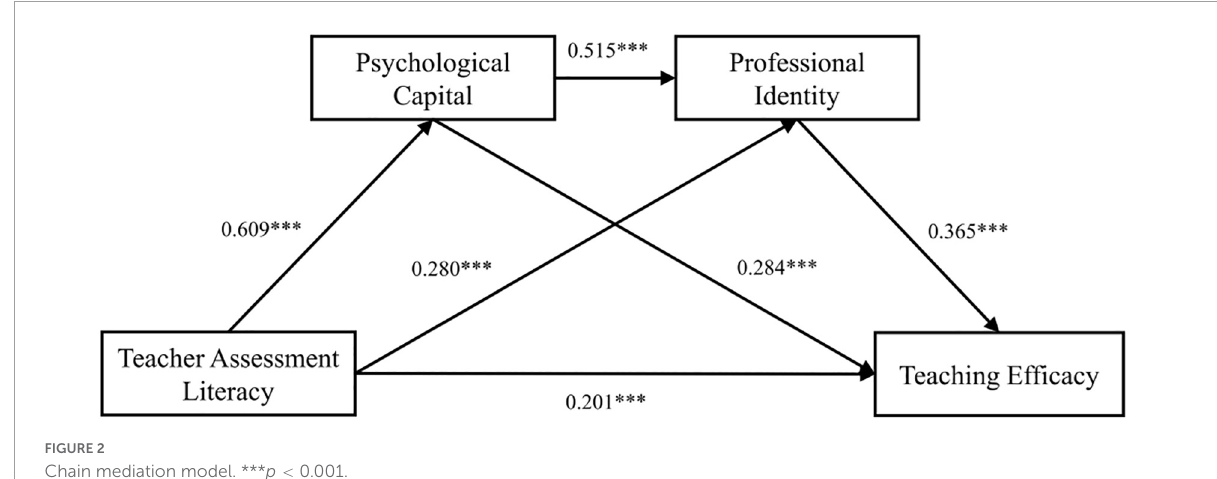
FIGURE2 Chain mediation model. *** p <